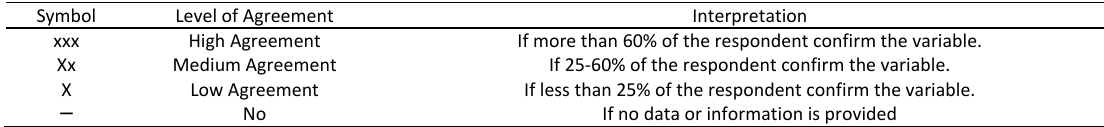
Table 3: Agreement levels for findings modified from Kleemann et al . (2017)